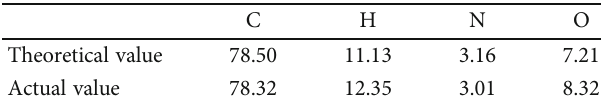
Figure 2: Synthesis route of glycine cholesterol ester. Table 5: Elemental composition of Boc-glycine cholesterol ester. Table 7: Elemental composition of glycine cholesterol